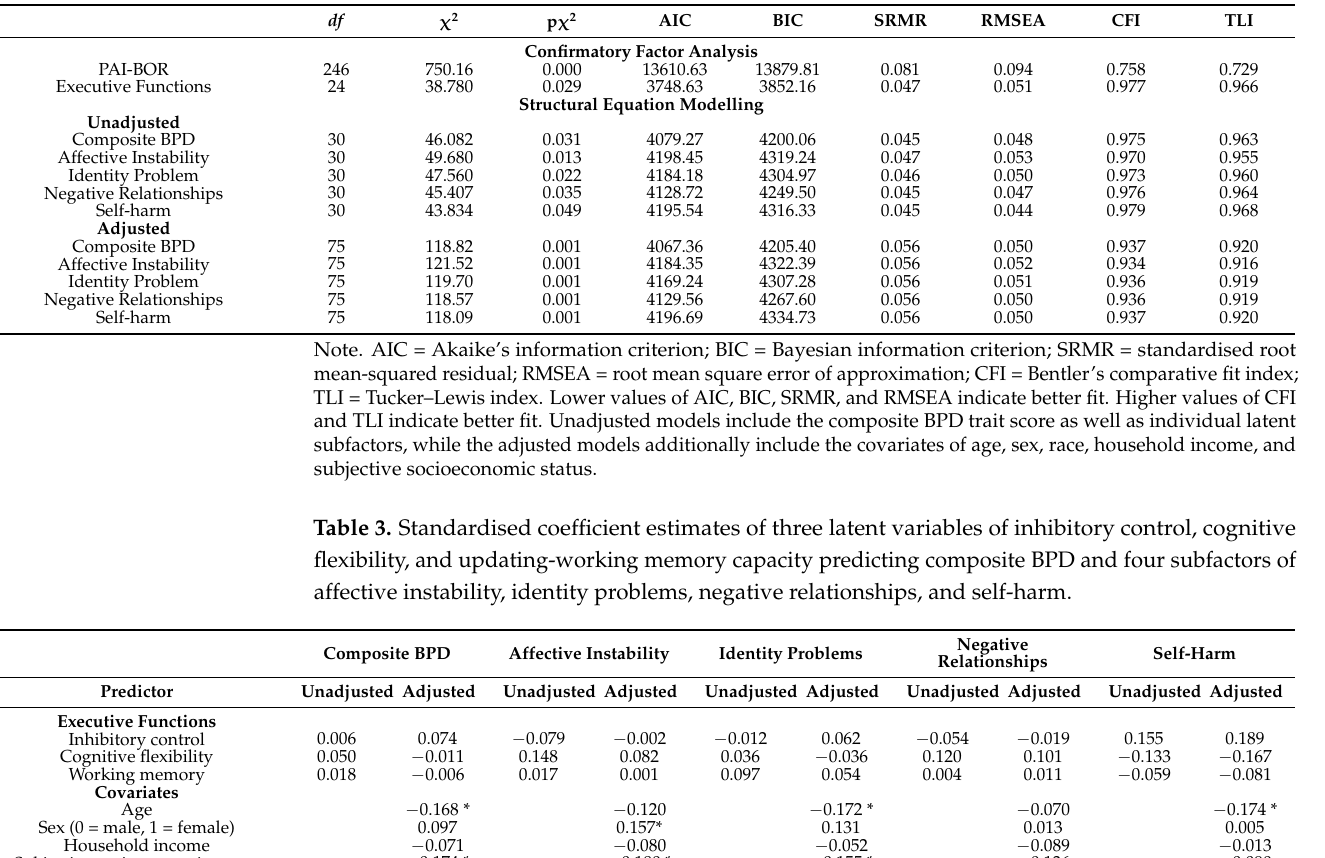
Table 2. Summary of model fits.